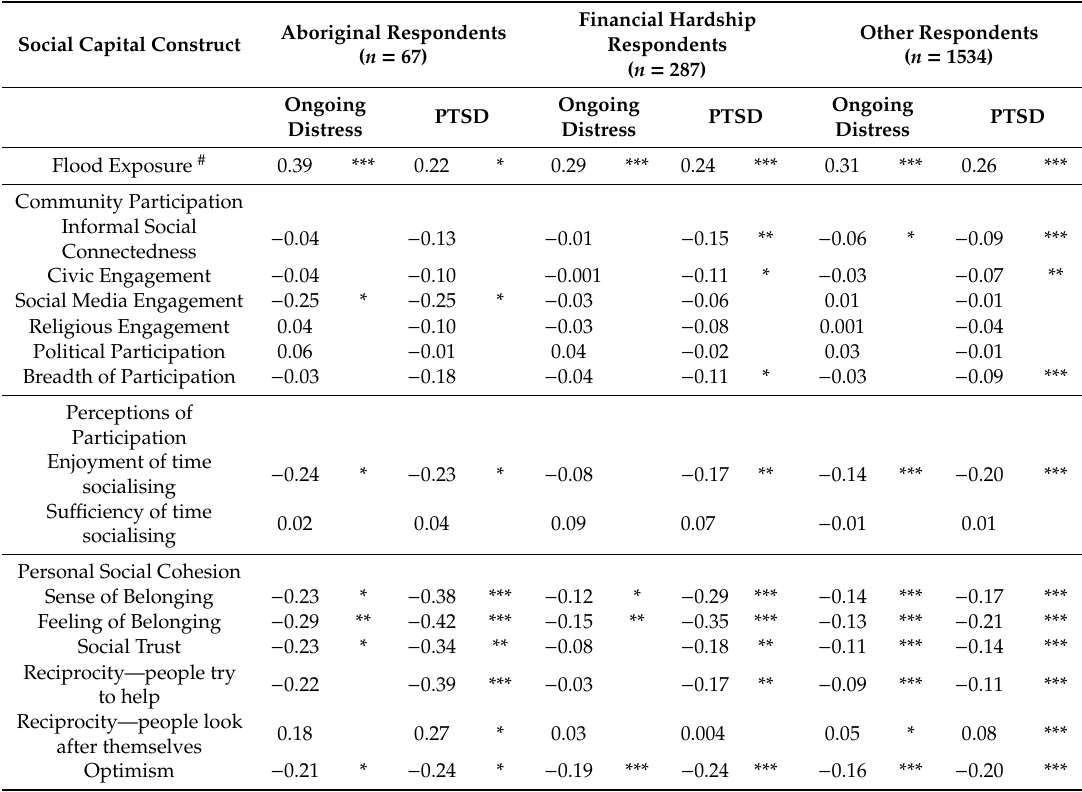
Table 5. Kendall Rank Correlation Coe ffi cients between social capital variables and mental health outcomes for each respondent